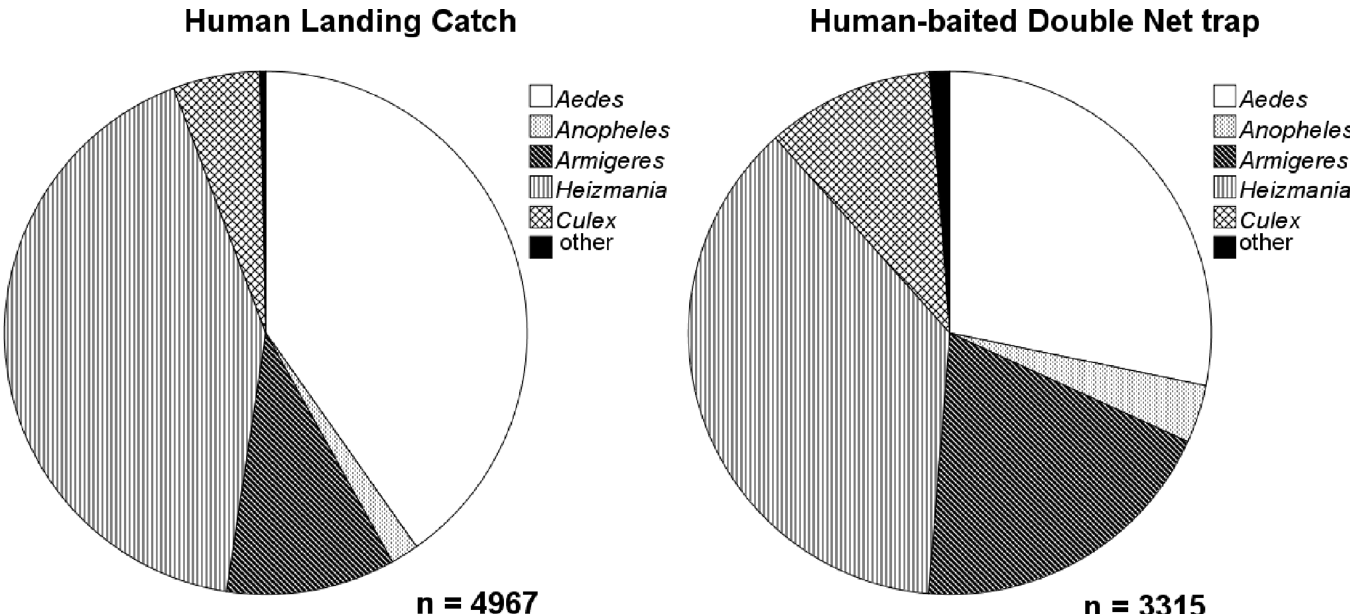
Fig 2. Species diversity of mosquitoes collected by the human landing catch method and human-baited double net traps (experiment 2).